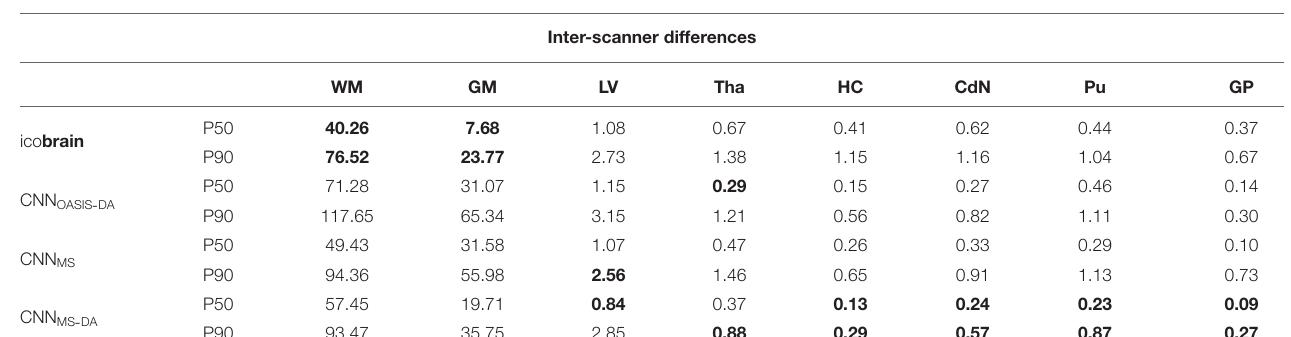
Best results are highlighted.